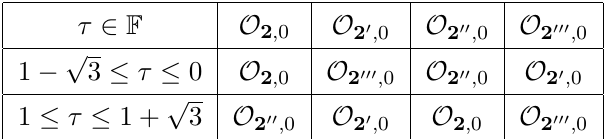
p 3 to doublets in the fundamental